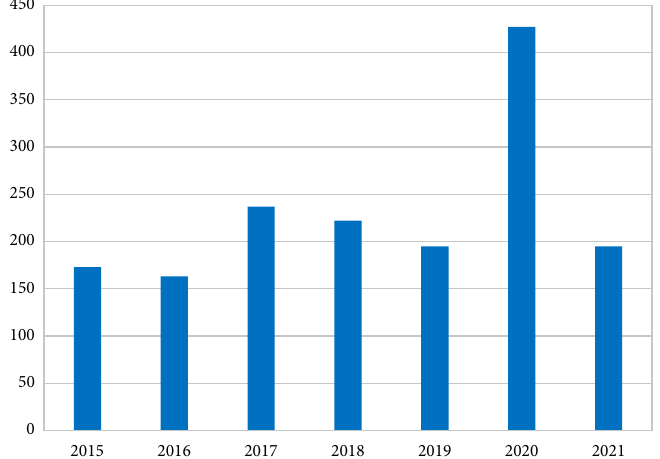
Figure 8. Average transaction volume per year (in PLZ) (source: own